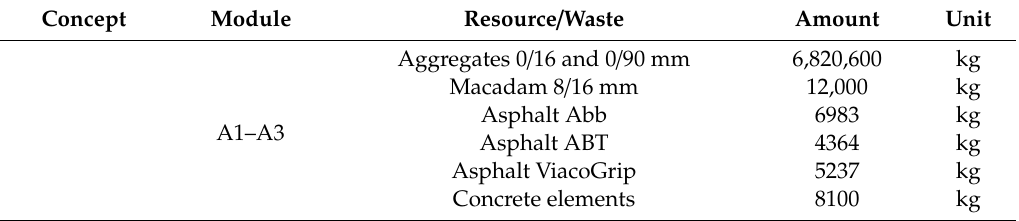
Table A2. Bill of materials (BOM) for the design concepts for each module. Amounts are representative of the required service life (RSL) and for the bridges as a whole. The amounts for modules B1–B8, C1–C4 and D were calculated based on the scenarios presented in Tables